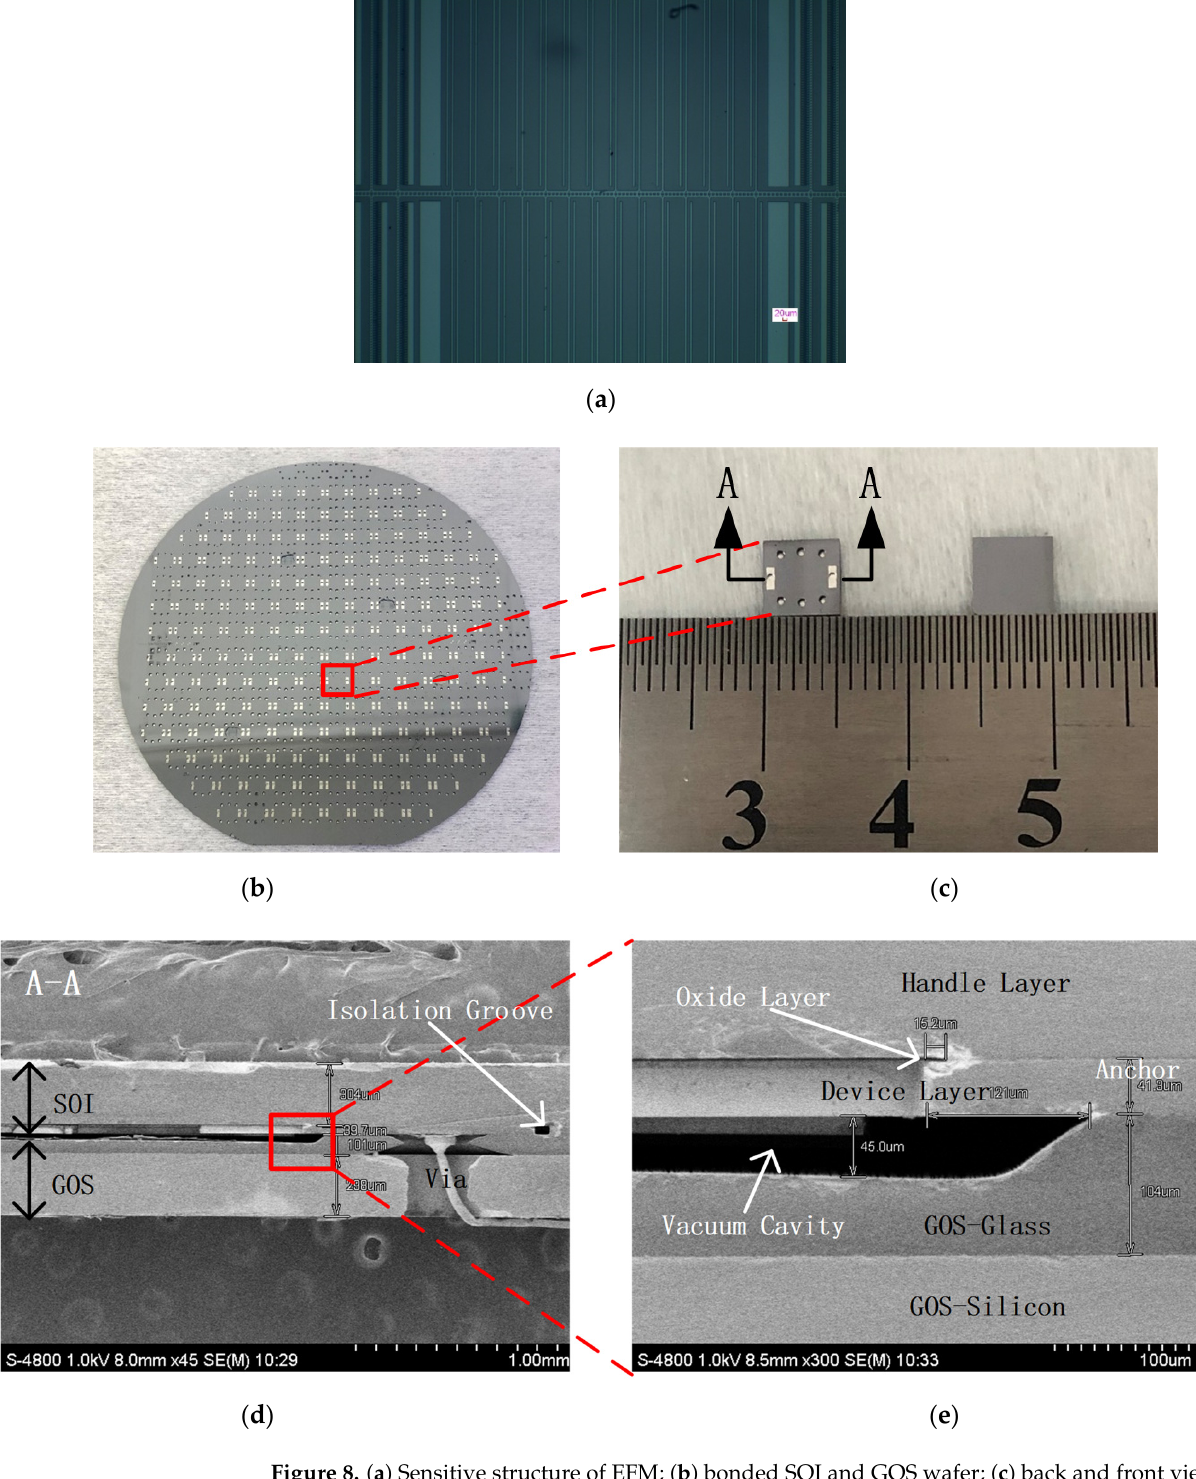
Figure 8. ( a ) Sensitive structure of EFM; ( b ) bonded SOI and GOS wafer; ( c ) back and front views of the chip after dicing; ( d , e ) cross-sectional SEM photographs of the bonded SOI and GOS wafer.